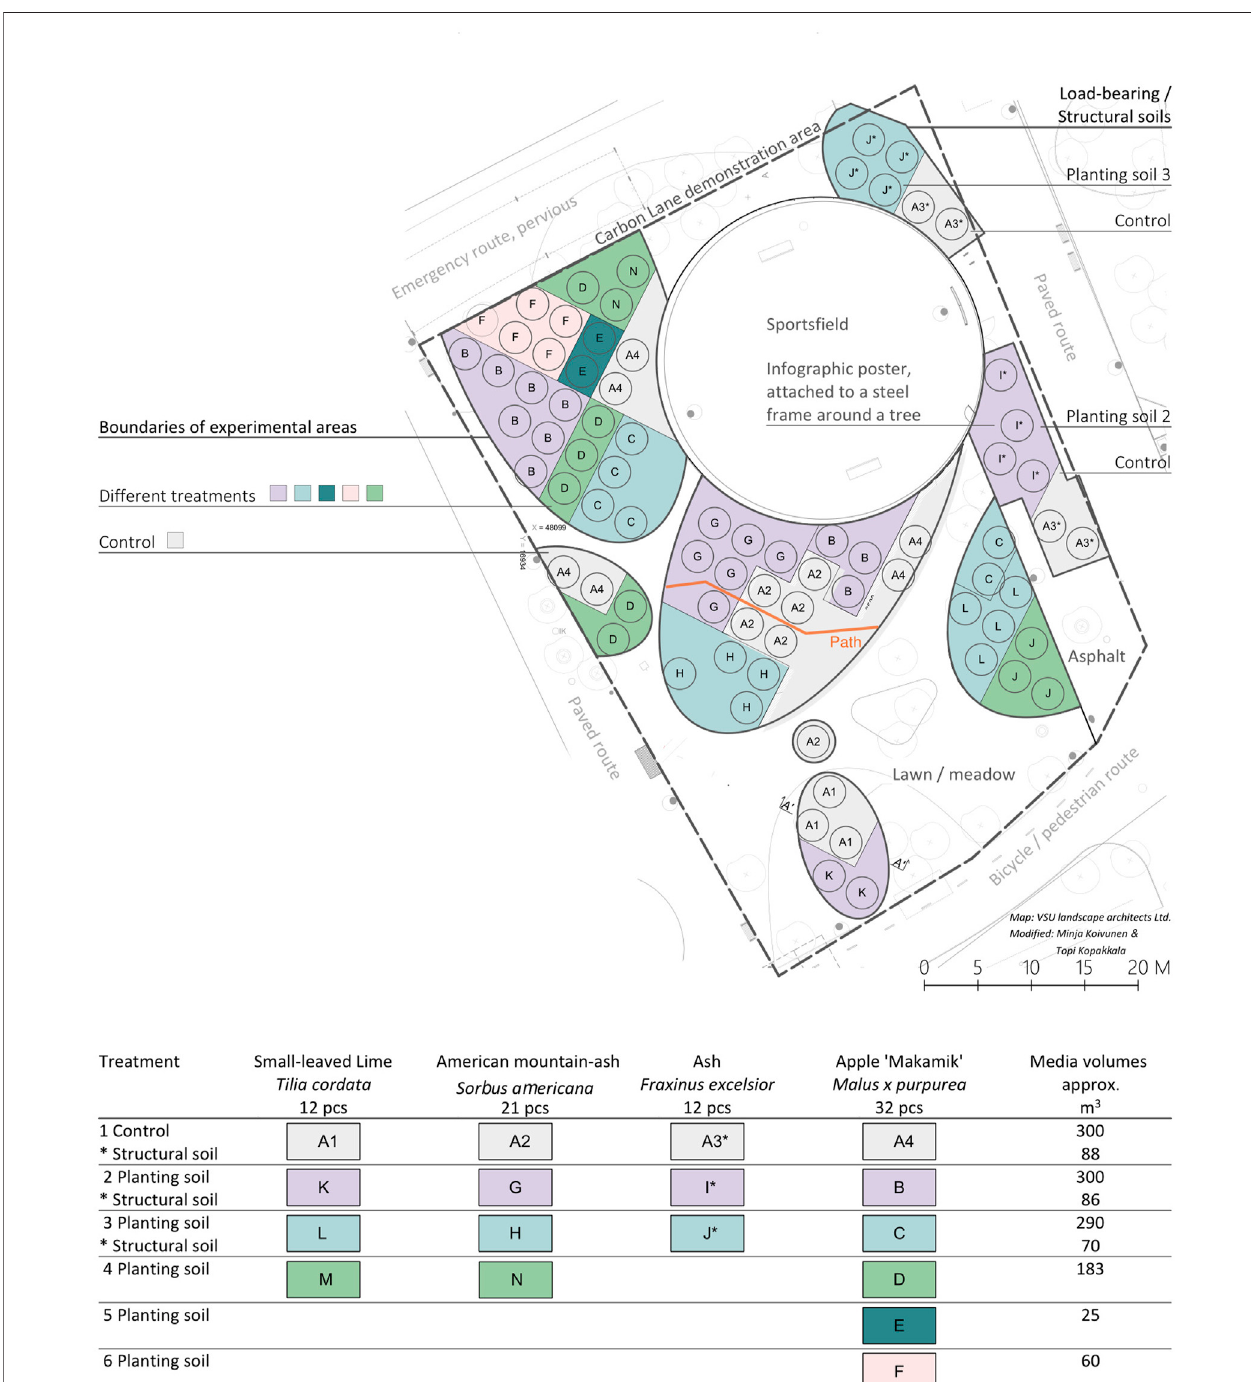
FIGURE 3 | The fi nal plan of the Jätkäsaari demonstration